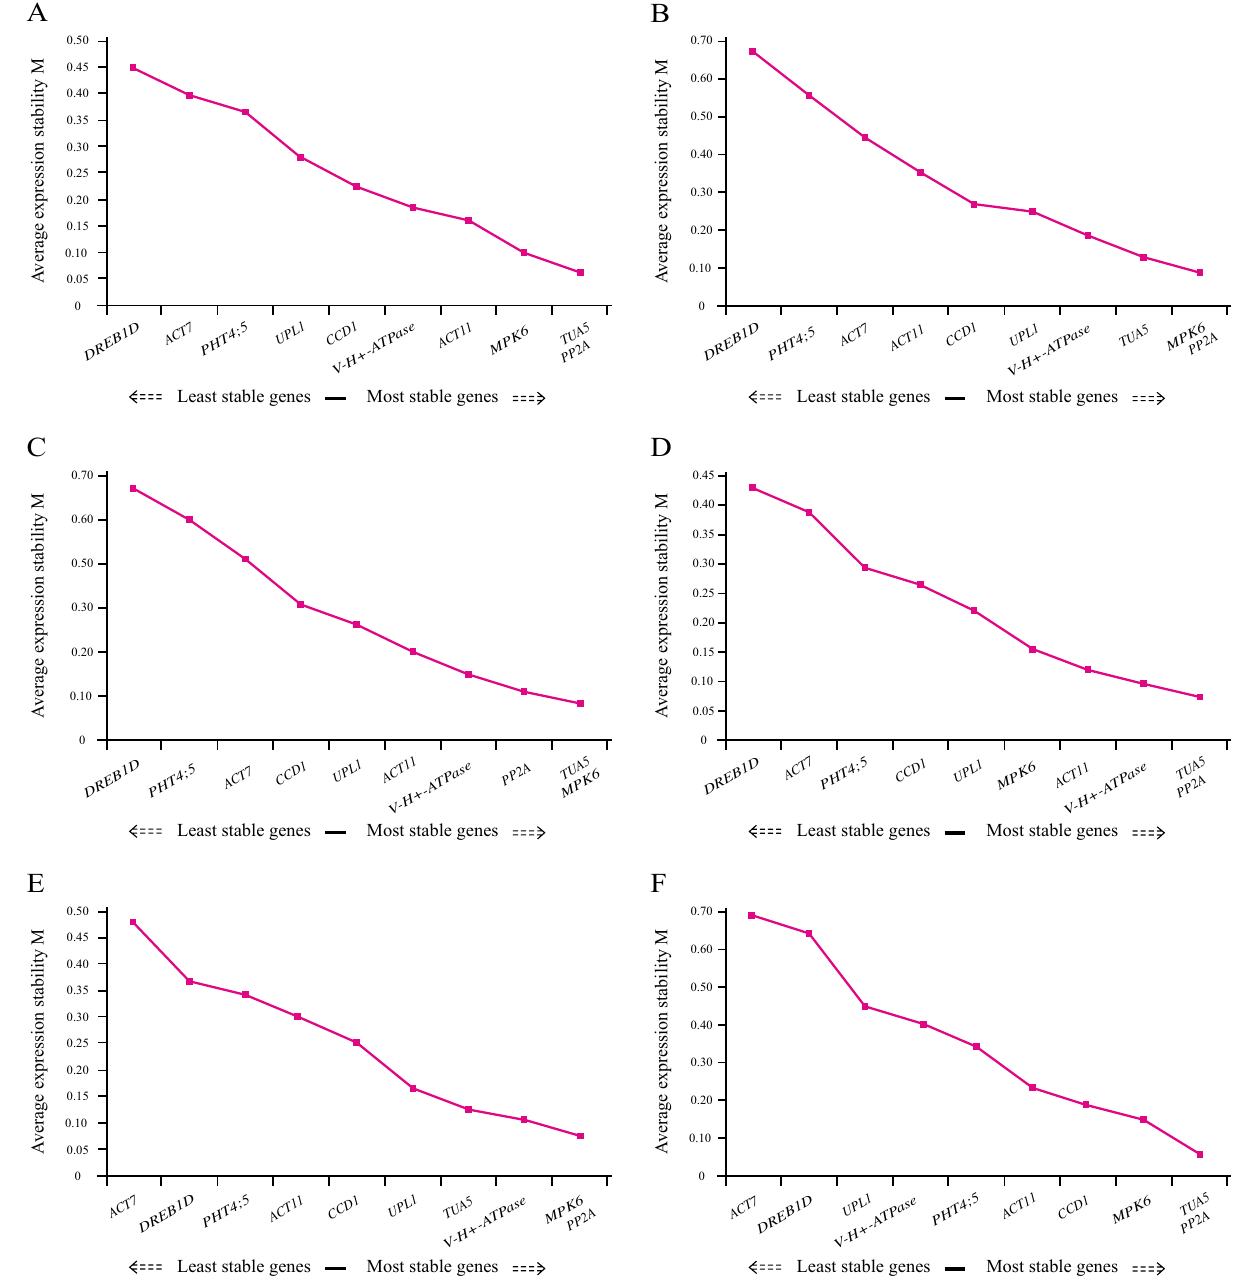
Figure 2. Gene expression stability values ( M ) of ten candidate reference genes validated via geNorm program. The least stable genes are on the left with higher M -values, and the most stable genes are on the right with lower M -values. ( A ) Thirteen tissue samples derived from 1/10 MS liquid medium treatment. ( B ) Thirteen tissue samples derived from 100 mM NaCl treatment. ( C ) Thirteen tissue samples derived from 300 mM NaCl treatment. ( D ) Fifteen germinating seed samples derived from NaCl gradient treatment. ( E ) Eighteen seedling samples derived from NaCl gradient treatment. ( F ) All 72 samples used in this BestKeeper analysis. The SD and r value of candidate reference genes in each treatment are listed in Table 3. Similar to the results of geNorm and NormFinder analysis, the three most stable genes were MPK6 , PP2A , and TUA5 , whereas DREB1D was the least stable gene in tissues (1/10 MS liquid medium). In addition to PP2A , TUA5 , and MPK6 , V-H + -ATPase was regarded as relatively stable in tissue experiments, both in 100 and 300 mM NaCl treatments. However, the two least stable genes in tissues after 100 mM NaCl treatment were DREB1D and ACT7 . DREB1D and PHT4;5 were the two least stable genes in 300 mM NaCl-treated tissues. For seed and seed- ling experiments, the top three most stable genes were again PP2A , TUA5 , and MPK6 , whereas DREB1D was the least stable gene for the two experiments. Overall, in the total samples, similar to the geNorm and NormFinder